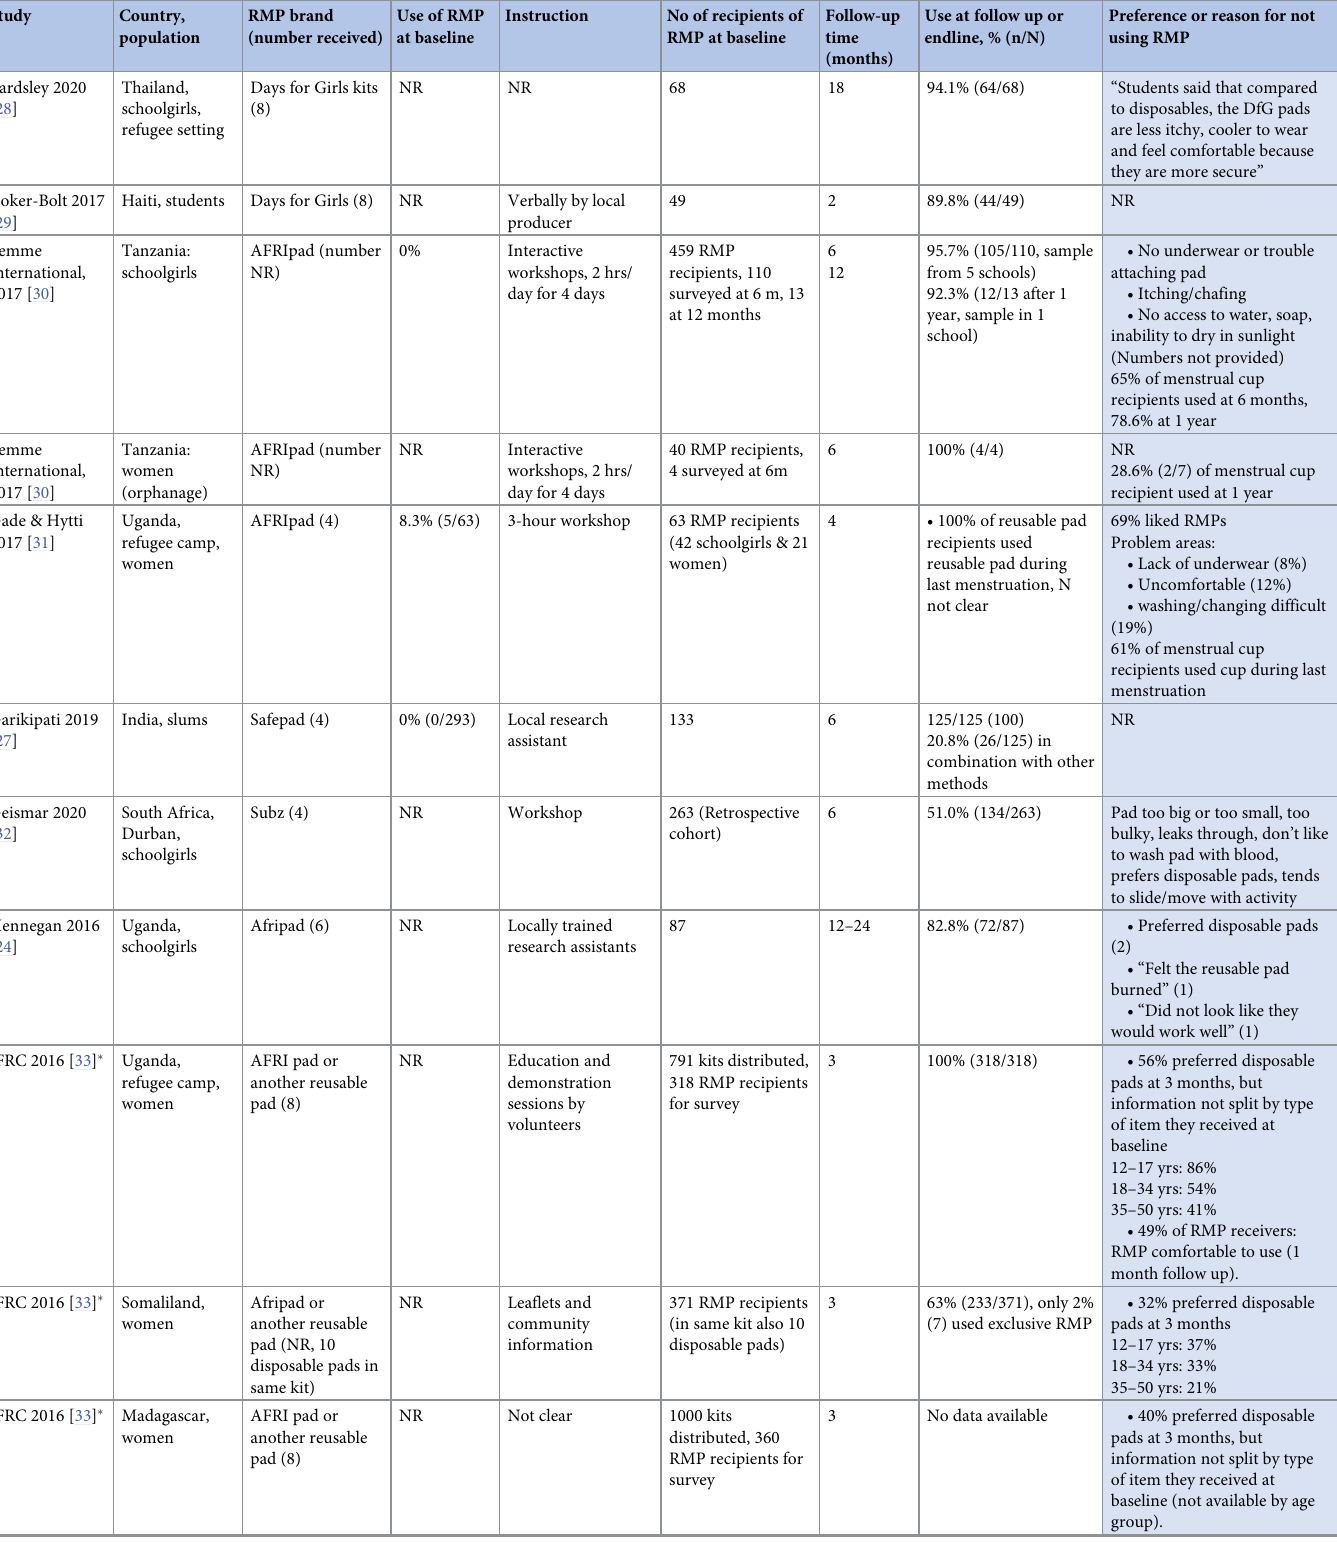
Table 2. Uptake of reusable menstrual pads in cohort studies. Study Country,